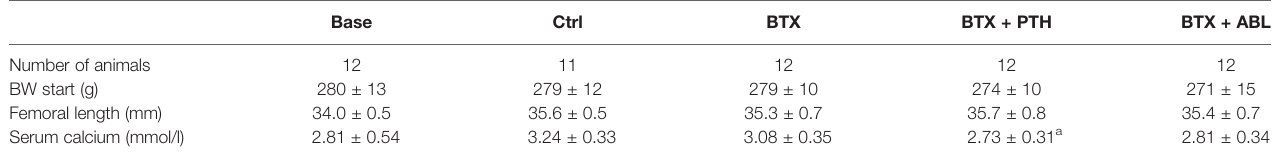
TABLE 1 | Number of animals, BW at study start, BW at study end, femoral length, rectus femoris muscles mass, and ionized calcium in serum of rats injected with BTX into the right hindlimb and treated with PTH or